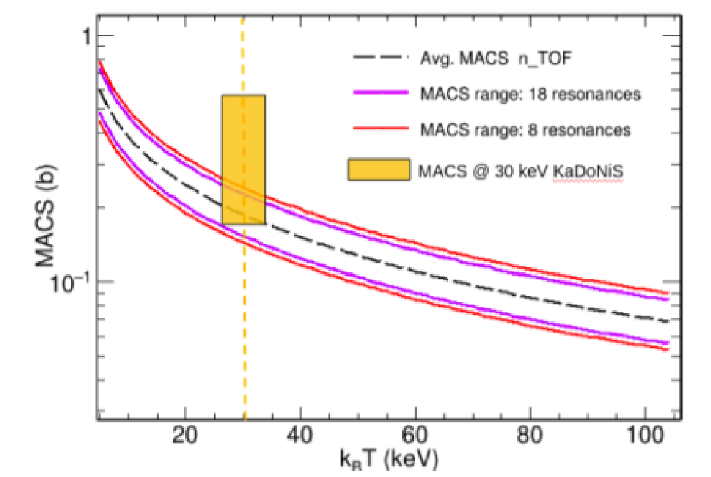
Figure 7. Expected MACS at di ff erent stellar temperatures (black dashed) and uncertainty range related to the limited number of observed resonances compared to the range of theoretical calculations compiled in